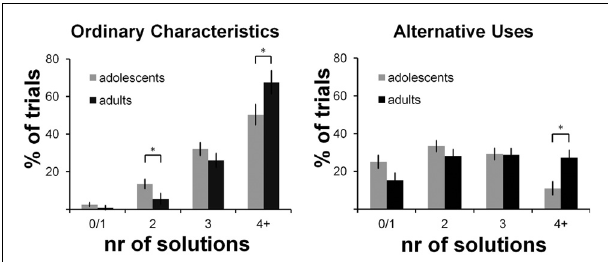
FIGURE 2 | Performance on the AUT-scanner task. Percentage of trials (y-axis) for which a certain number of solutions (x-axis) is generated. Results for the Ordinary Characteristics condition are presented on the left; results for the Alternative Uses condition are presented on the right. ∗ ≤ 0 . 05.